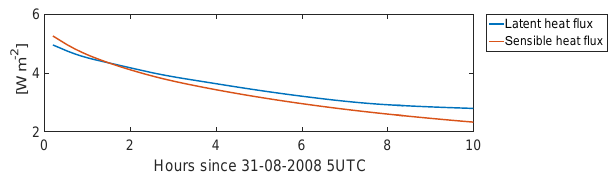
Figure 6. Mean latent heat flux (blue) and mean sensible heat flux (red) for the control